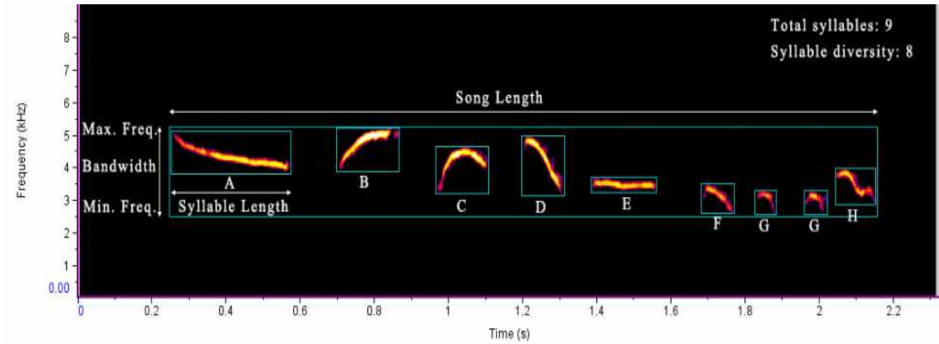
Figure 2. An example of the territorial song of the oriental magpie-robin and measurement of the song variables in the spectrogram. A–H stands for different syllable